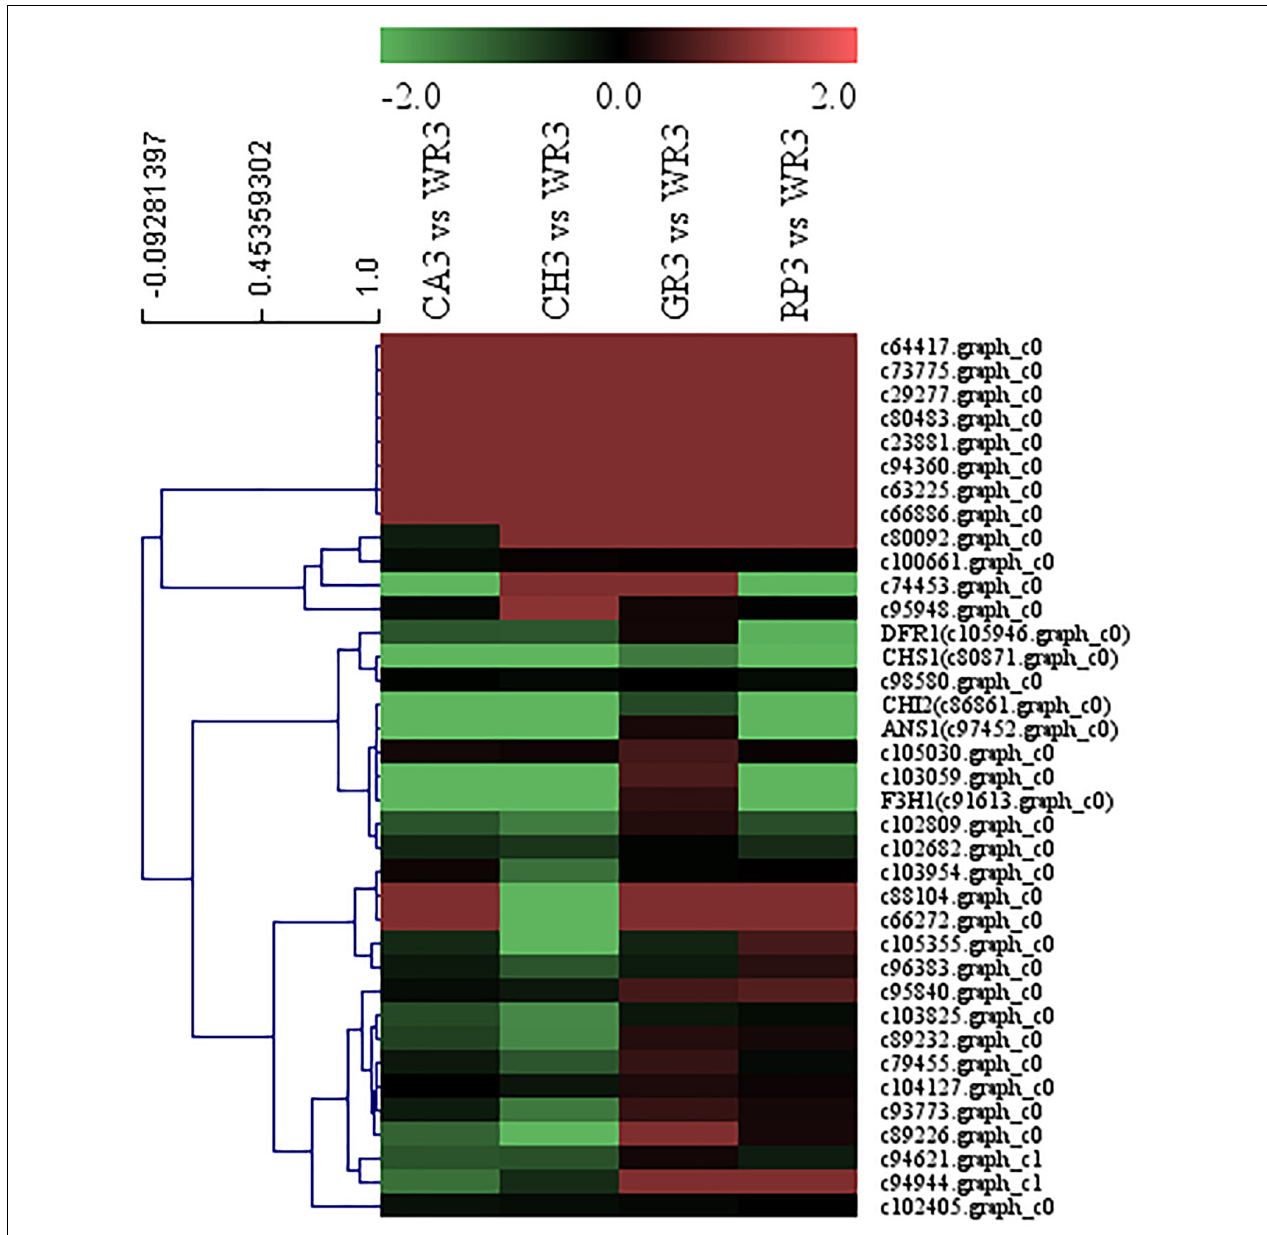
FIGURE 4 | Cluster thermogram of WRKY with key structural genes in flavonoid biosynthesis process of Freesia hybrida